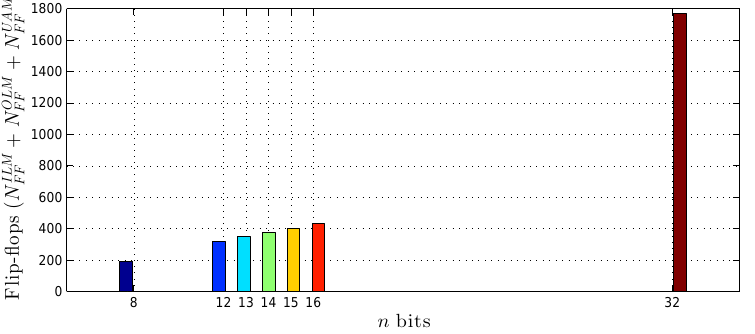
Figure 9. Area occupied (flip-flops) for different fixed point formats, in the XOR gate scenario.